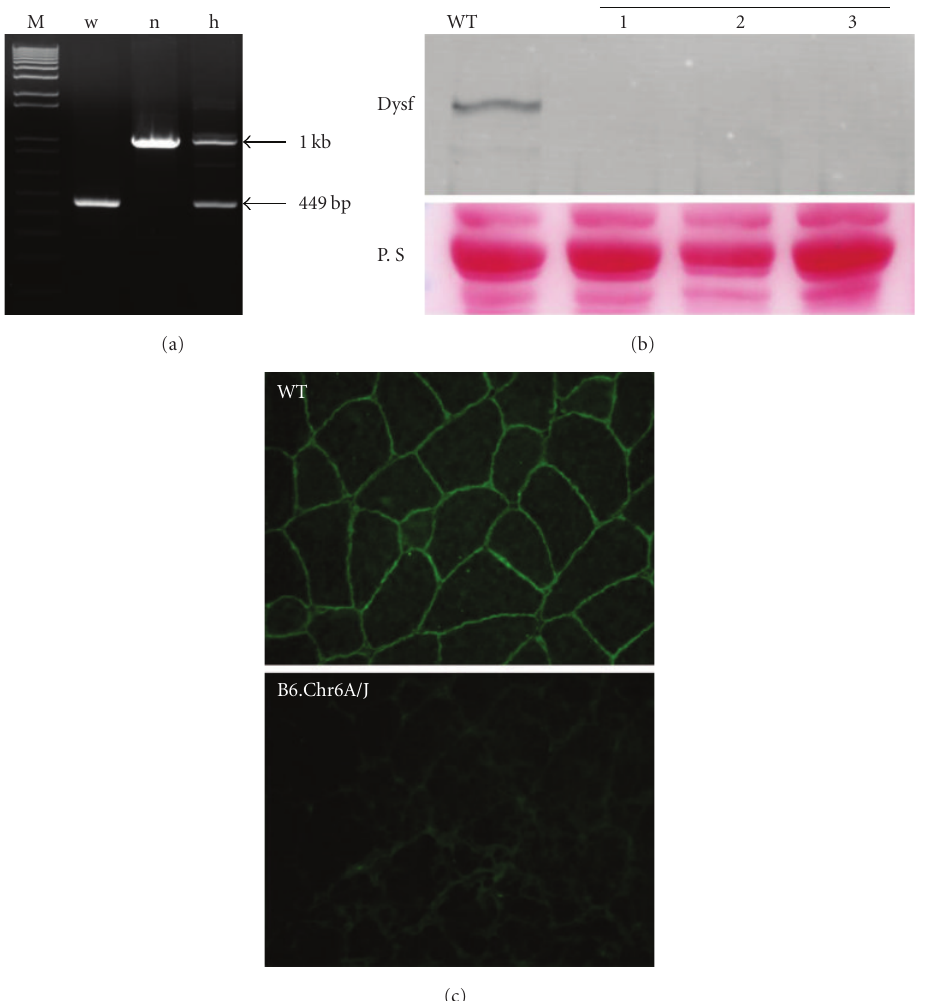
Figure 1: Disrupted expression of dysferlin in skeletal muscle of C57BL/6J-Chr6 A / J /NaJ mice. (a) PCR genotyping of WT (w), C57BL/6J- Chr6 A / J /NaJ (n), and heterozygous (h) mice. (b) Western blotting analysis of the quadriceps muscles from WT and C57BL/6J-Chr6 A / J /NaJ (B6.Chr6A/J) mice using the monoclonal anti-dysferlin antibody (Dysf). The bottom panel is the same blot stained with Ponceau-S (P.S). (c) Immunofluorescence labeling of muscle sections from WT and dysferlin-deficient mice with anti-dysferlin antibody.